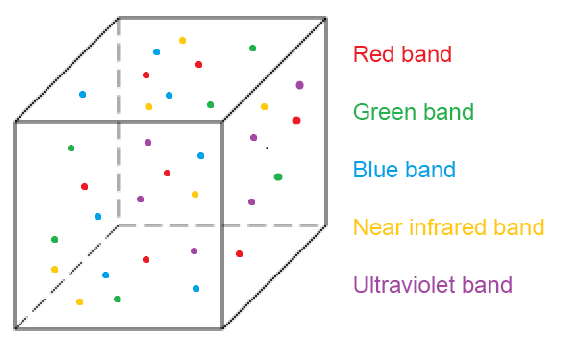
Figure 15. Definition of a multispectral voxel.